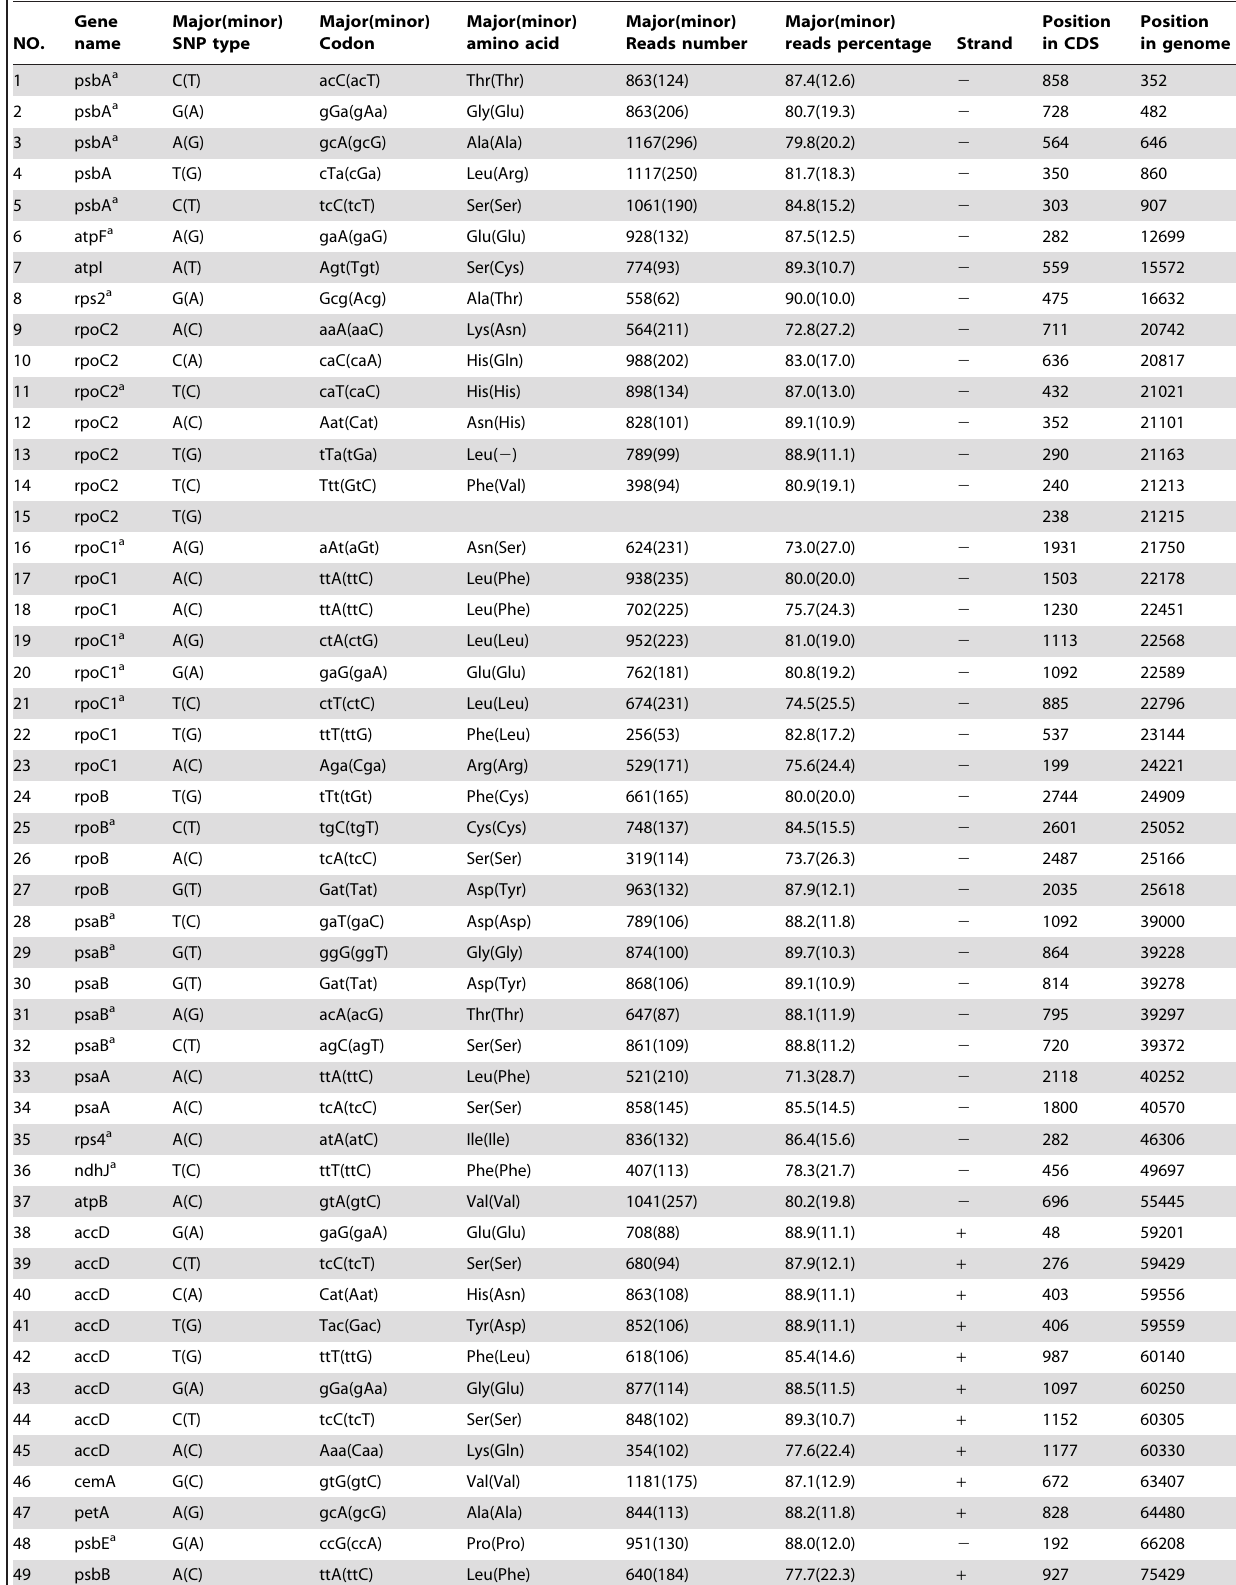
Table 4. The intravarietal SNPs found in coding region of date palm chloroplast genome.